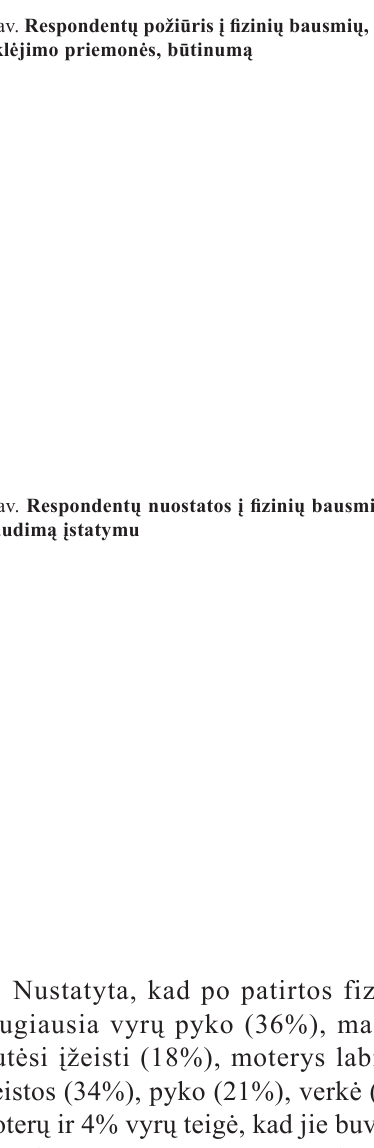
neprasikalt ę taip, kad prieš juos b ū t ų panaudota fi zin ė bausm ė